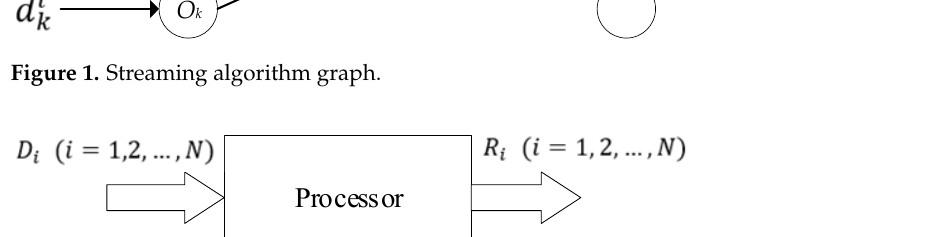
Figure 1. Streaming algorithm graph. Figure 2. Operations in typical computer with von Neumann architecture.